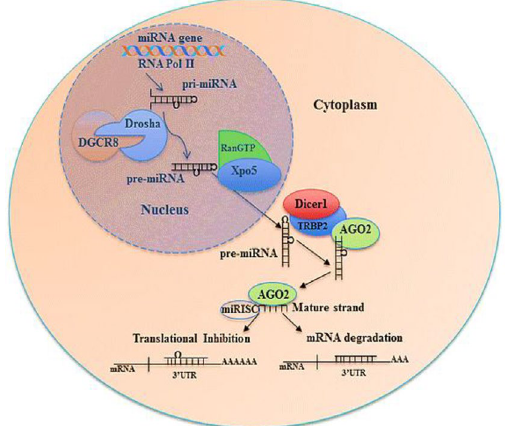
Fig. 1. The way undergone by a miRNA from generation to mat- uration and function. Reprinted with the permission from ref.